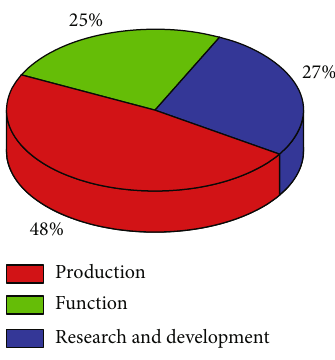
Figure 5: Distribution of survey sample structure by business